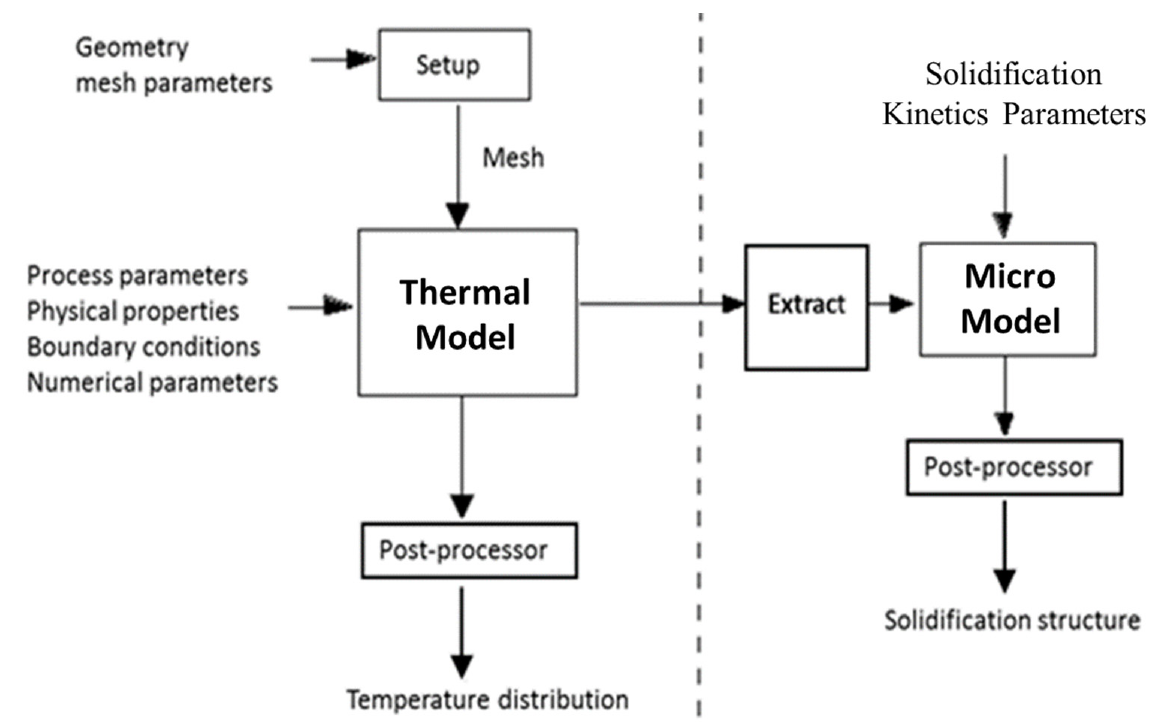
Figure 1. Diagram showing the coupling between the 3D thermal code and the 3D solidification structure evolution code.